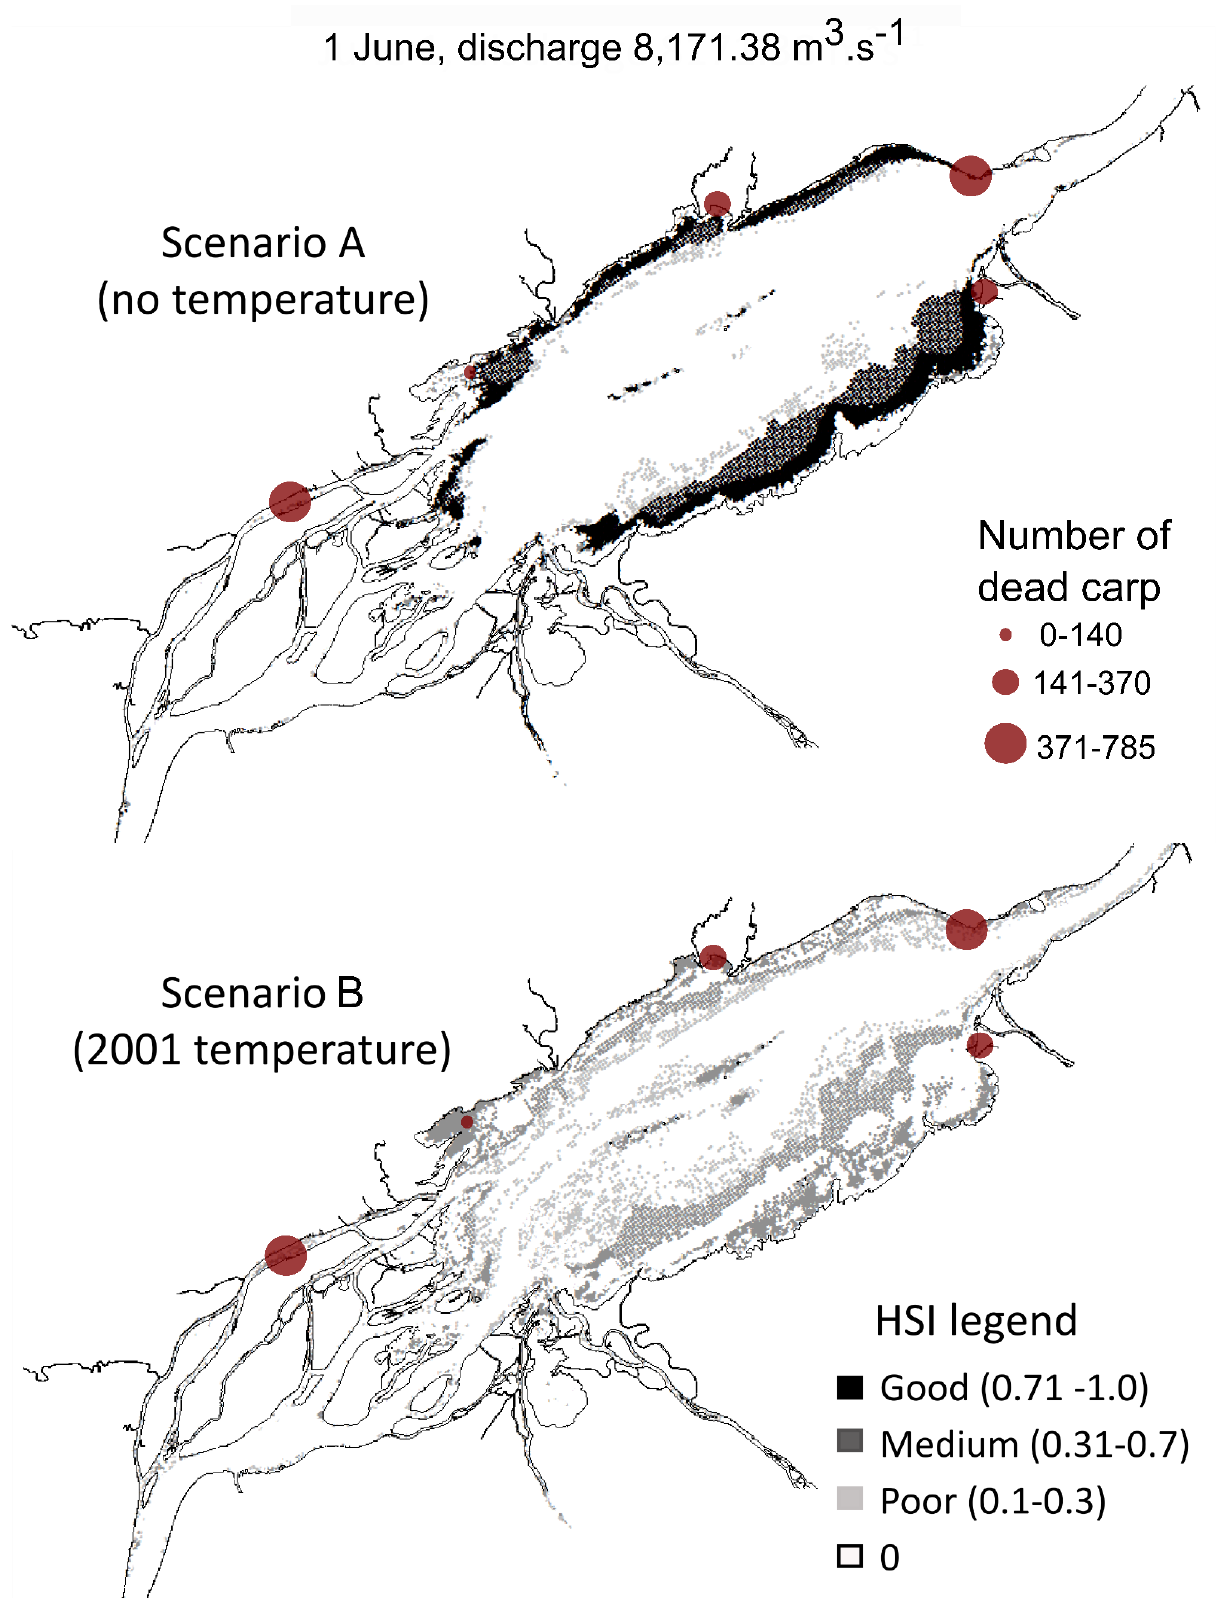
Figure 5. Spatial distribution of habitat suitability index (HSI) for the carp spawning habitat in the Lake Saint-Pierre area simulated for 1 June 2001, during the mortality period. Two scenarios were computed: ( A ) excluding water temperature and ( B ) including water temperature as simulated for